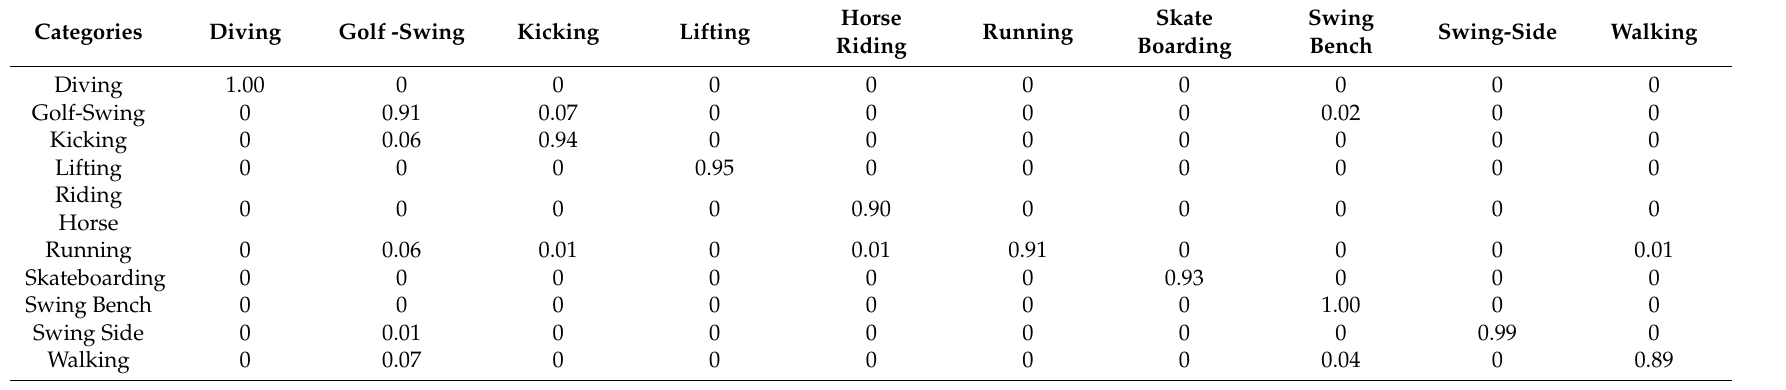
Table 3. Confusion matric of UCF sports